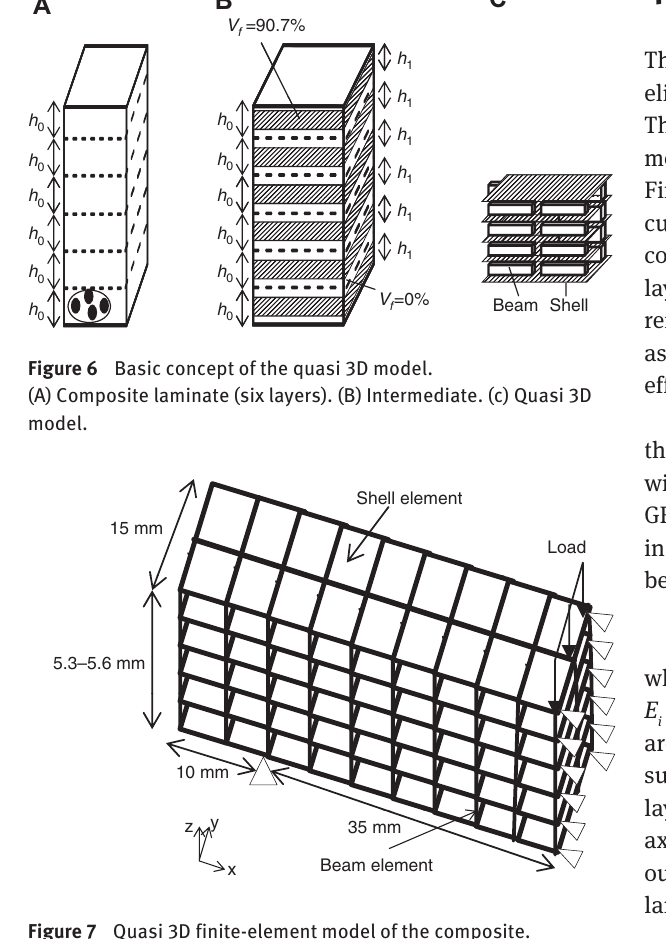
Figure 7 Quasi 3D finite-element model of the composite.